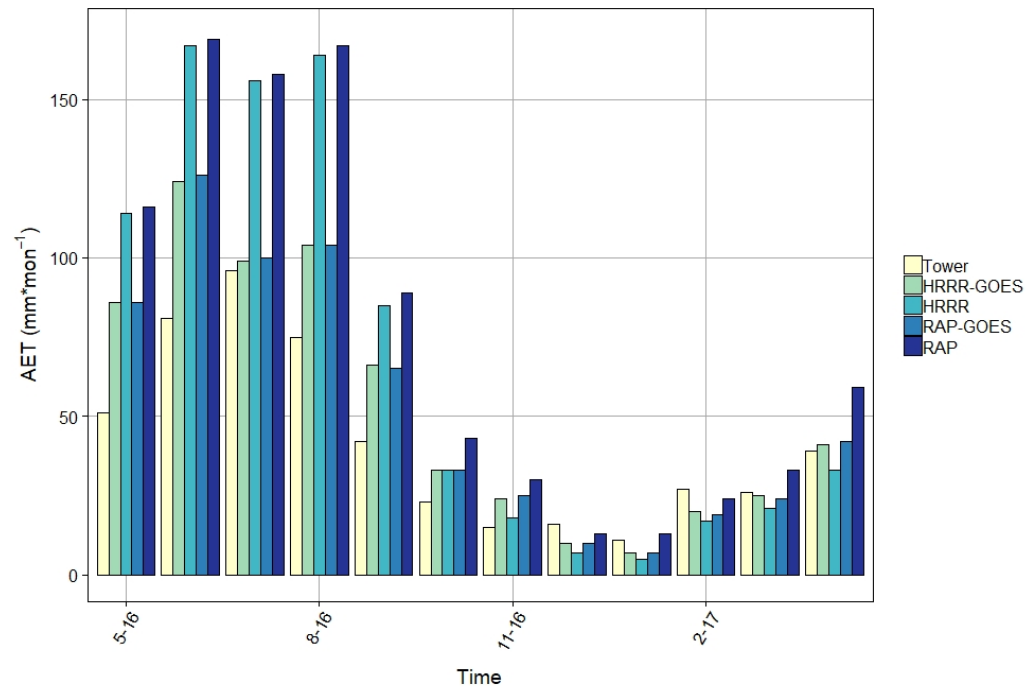
Figure 10. Monthly AET comparisons of the tower vs. model estimates at Tower 11.